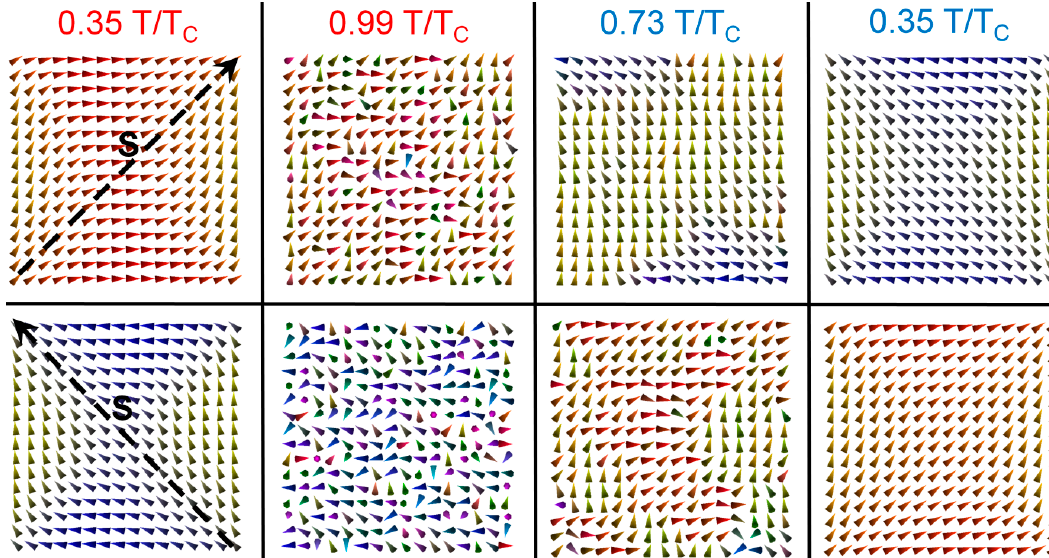
Figure 4. Magnetisation switching simulations. Snapshots of the magnetisation configuration are shown at different temperatures, illustrating the switching process. The top row starts from state “1” with a stress applied to induce switching to state “0”. The bottom row starts from state “0” and switches to state “1”.